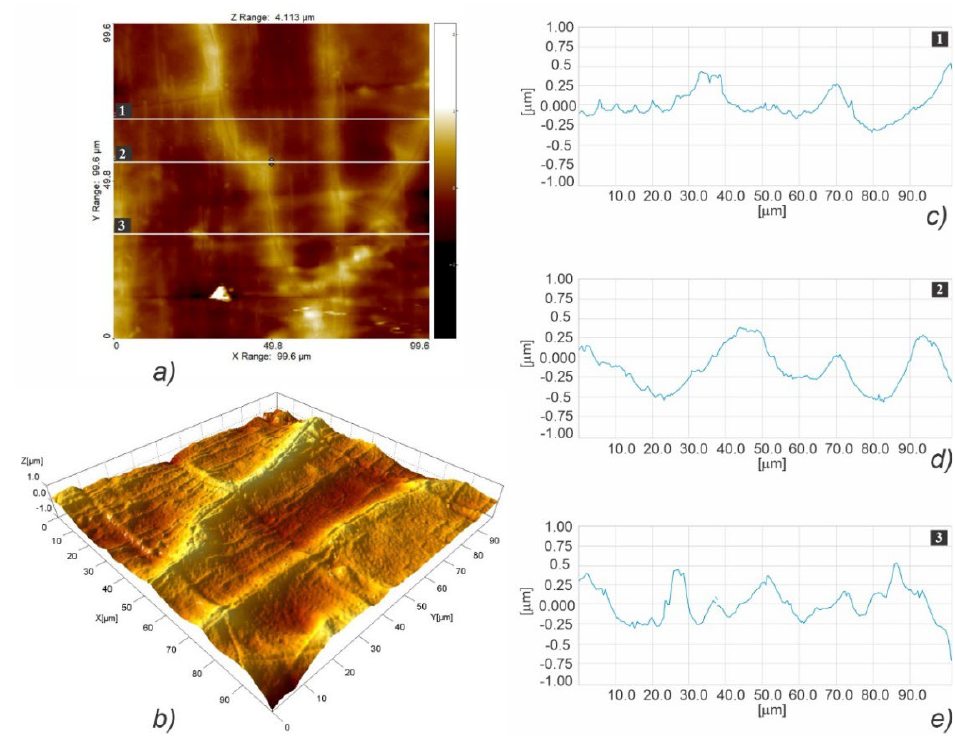
Figure 10. AFM topographic images obtained for the HLC scaffold over 100 × 100 µm area ( a , b ), and the corresponding profiles taken at locations marked with 1 ( c ), 2 ( d ), and 3 ( e ).